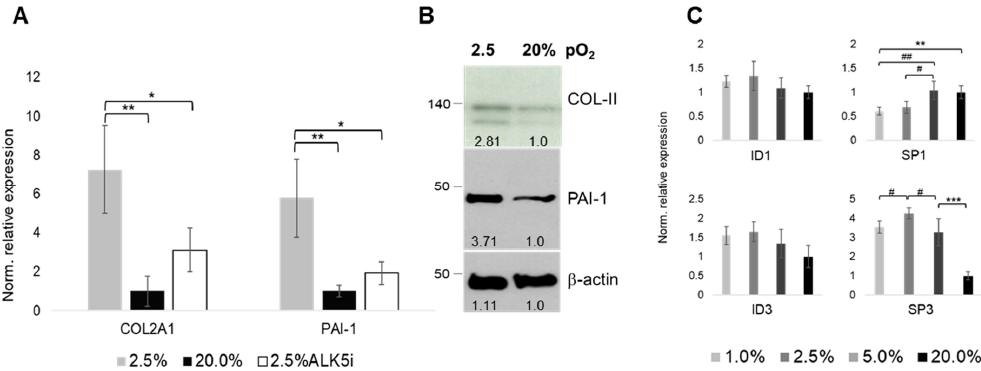
Figure 6. Oxygenation ‐ tension and ALK5 ‐ dependent expression of collagen type II, next to PAI ‐ 1 and selected downstream targets ID and SP. Normalized relative mRNA expression of type II collagen (COL ‐ II, i.e., COL2A1 ) next to that of ALK5 ‐ Smad2/3 downstream target PAI ‐ 1 (plasminogen activator inhibitor ‐ 1). Pharmacological inhibition of ALK5 (ALK5i) suggests its involvement in COL2A1 expression ( A ). Respective immunoblots showing protein abundances ( B ). Expression of ALK1 ‐ Smad1/5/8 ‐ target DNA ‐ binding proteins inhibitor ID1 and ID3 and transcription factors SP1 and SP3 , respectively ( C ). Selected oxygenation levels were 2.5% and 20% pO 2 , respectively. RT ‐ qPCR ( n = 5), Western blot ( n = 3); * p < 0.05, ** p < 0.01, *** p < 0.001.